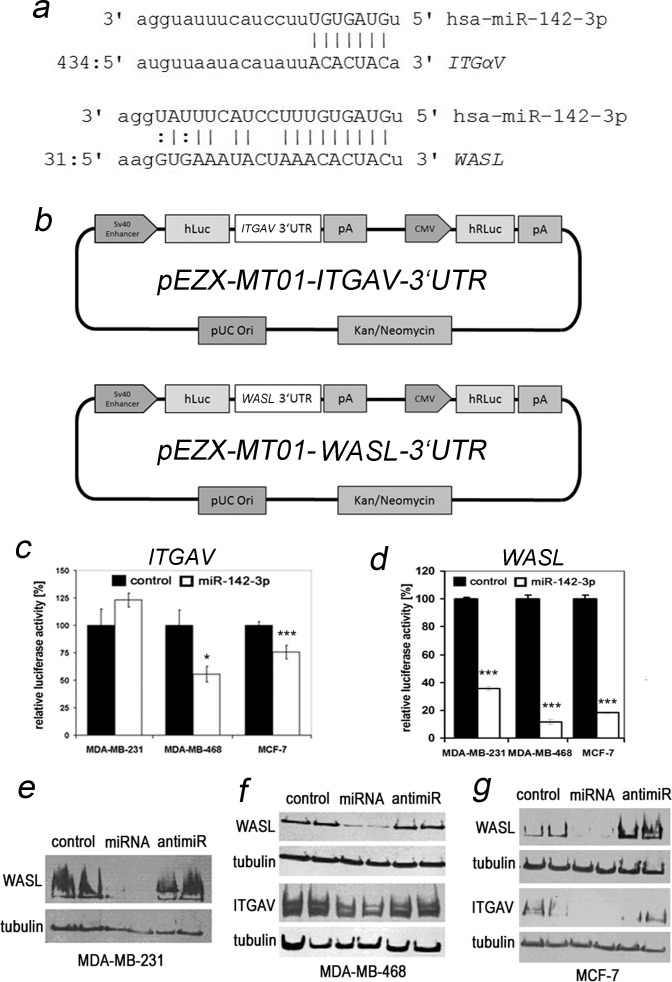
3’UTR luciferase assay and Western blotting identify Integrin alpha V and N-WASP as relevant regulatory targets of miR-142-3p.(a) Alignment of the seed sequence of miR-142-3p with predicted target sites of the 3’UTR of ITGAV (top) and one of the three predicted target sites of WASL (bottom) according to the microRNA.org database [28]. (b,c) The 3’UTR of ITGAV is a target for transcriptional regulation by miR-142-3p. Cells were transfected with plasmid pEZX-MT01-ITGAV-3’UTR (b, upper panel) expressing firefly luciferase (hLuc) under the control of an SV40 enhancer and the 3’UTR of human ITGAV, and renilla luciferase (hRLuc) under constitutive control of the cytomegalovirus (CMV) promoter. Cells were cotransfected with a control pre-miR or pre-miR-142-3p and simultaneously assayed for activity of both luciferases 72h after transfection. (b) pA = poly-A tail, pUCOri = origin of replication, Kan/NeomycinR = antibiotic resistance genes. (c) miR-142-3p transfection induced a significant decrease in ITGAV-specific normalized firefly luciferase activity in MCF-7 and MDA-MB-468, but not in MDA-MB-231 cells (N = 3, *P<0.05, ***P<0.001). (d) The 3’UTR of WASL is a target for transcriptional regulation by miR-142-3p Cells were transfected with plasmid pEZX-MT01-WASL-3’UTR (b, lower panel). Cells were cotransfected with a control pre-miR or pre-miR-142-3p and simultaneously assayed for activity of both luciferases 72h after transfection. WASL-dependent luciferase activity is reduced ranging from 64% to 88% in all three cell lines (N = 3, ***P<0.001). (e-g) Western blot confirmation of differentially regulated Integrin-αV and N-WASP protein expression in miR-142-3p vs. control transfected breast cancer cell lines. miR-142-3p upregulation inhibits N-WASP expression in all investigated cell lines (e-g), which can be reversed by anti-miR inhibition. miR-142-3p precursor transfection inhibits Integrin-αV expression in MDA-MB-468 (f) and MCF-7 (g) cells. The migration position of molecular weight markers relative to Integrin-αV and N-WASP is shown in S4 Fig.